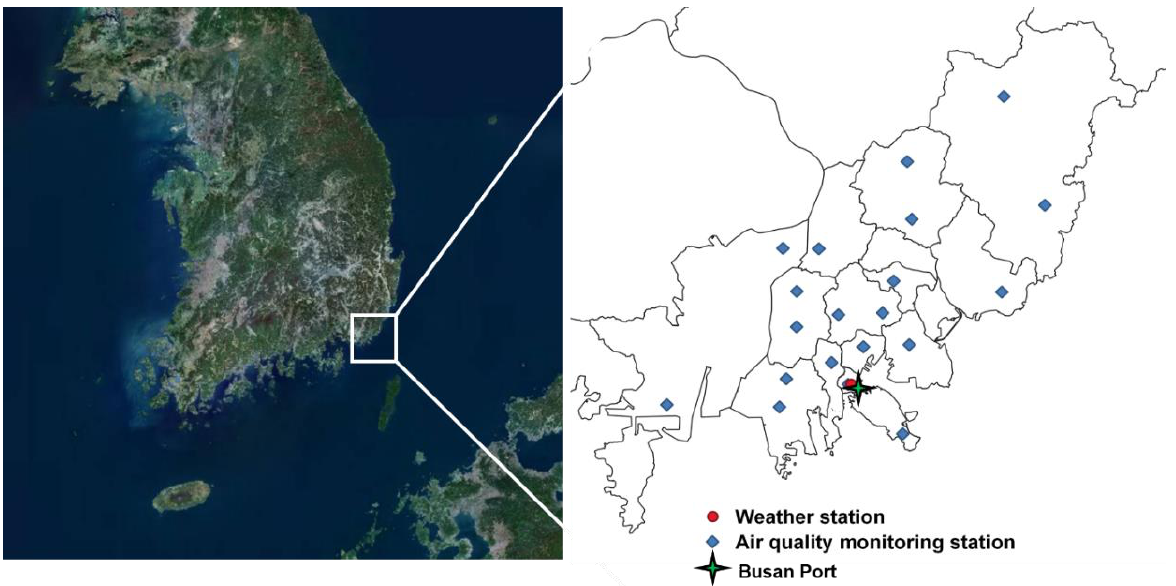
Figure 1. Location of Busan port and locations of weather and air quality monitoring stations. Left figure obtained from Google Maps. Table 1. Summary of WRF configuration.